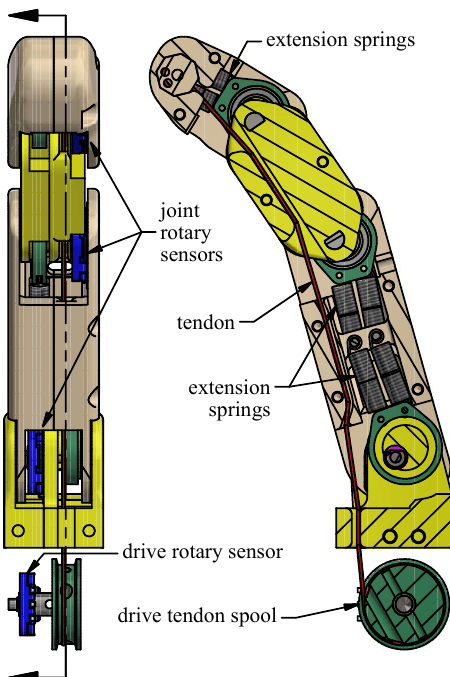
Figure 8. Mechanical design of an underactuated finger; design intended for ring and small fingers; drive motor not visible.